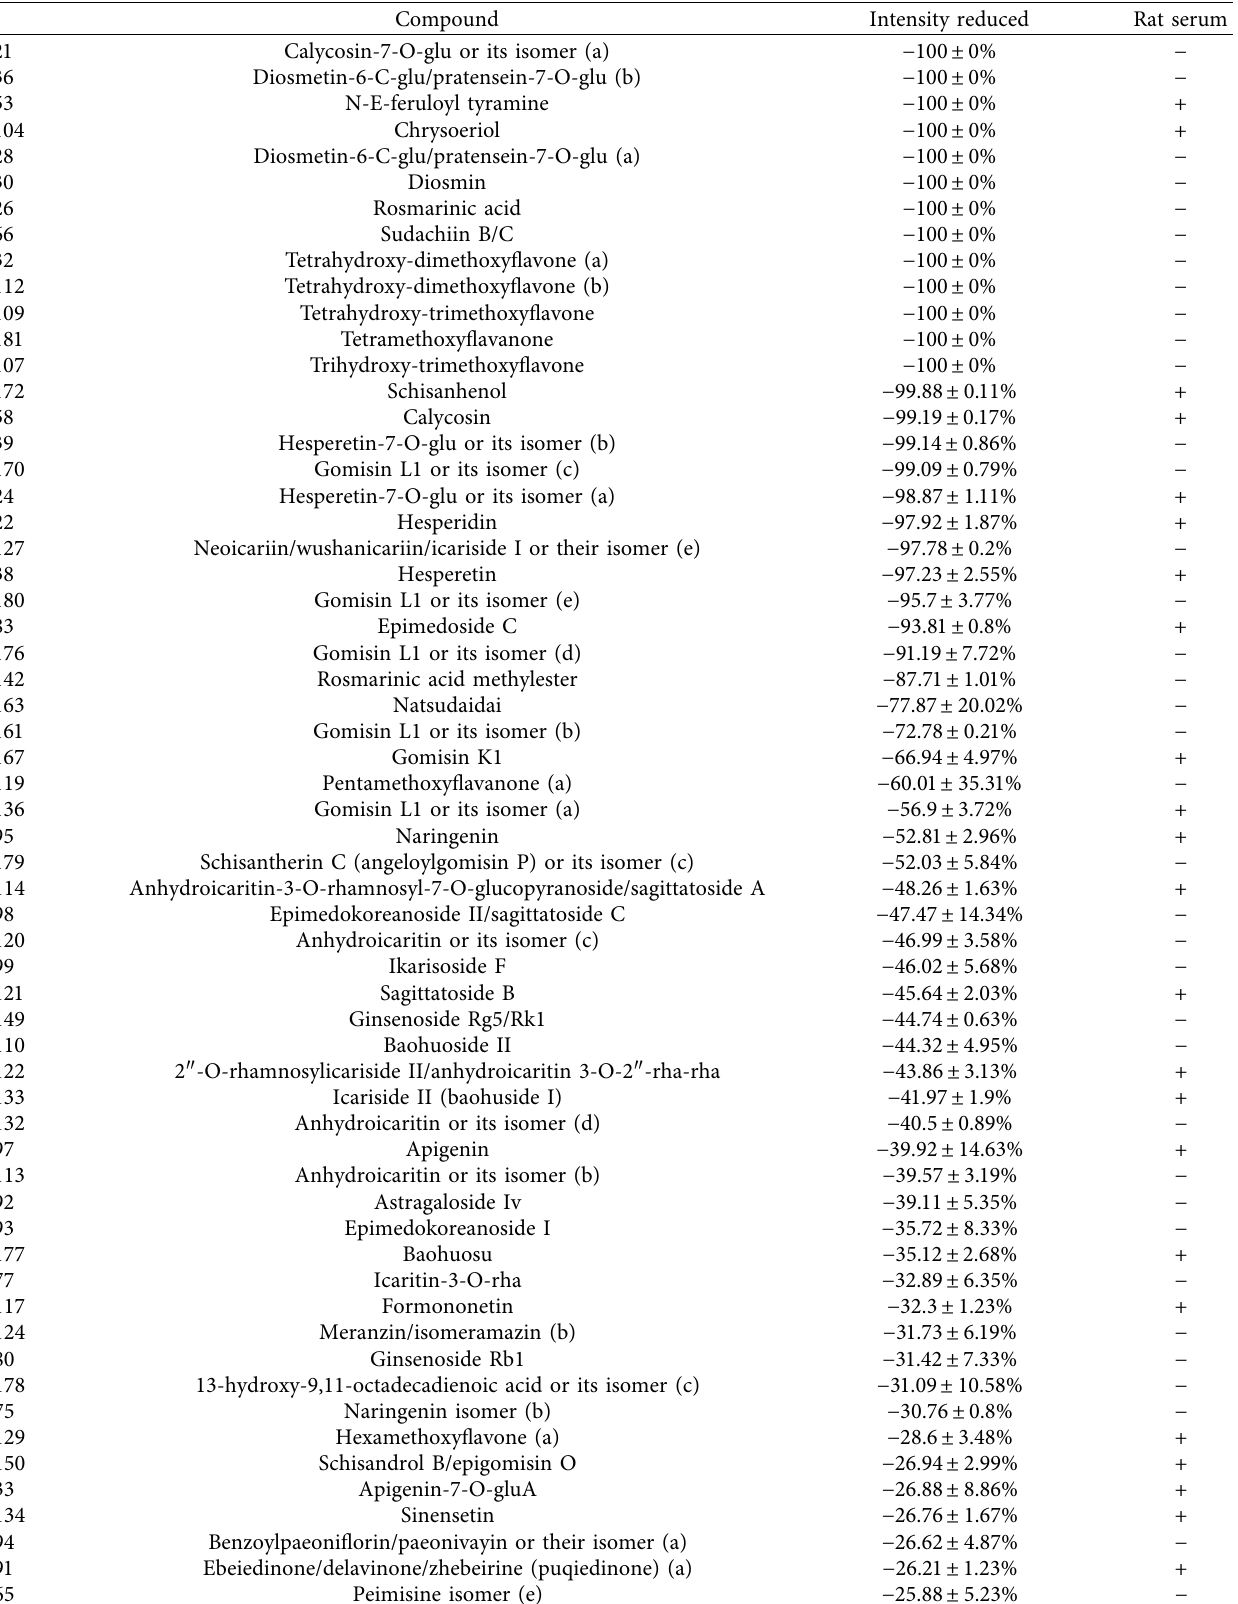
Table 3: Candidate antioxidants identified from BYF and rat serum after the oral administration of BYF (10mM